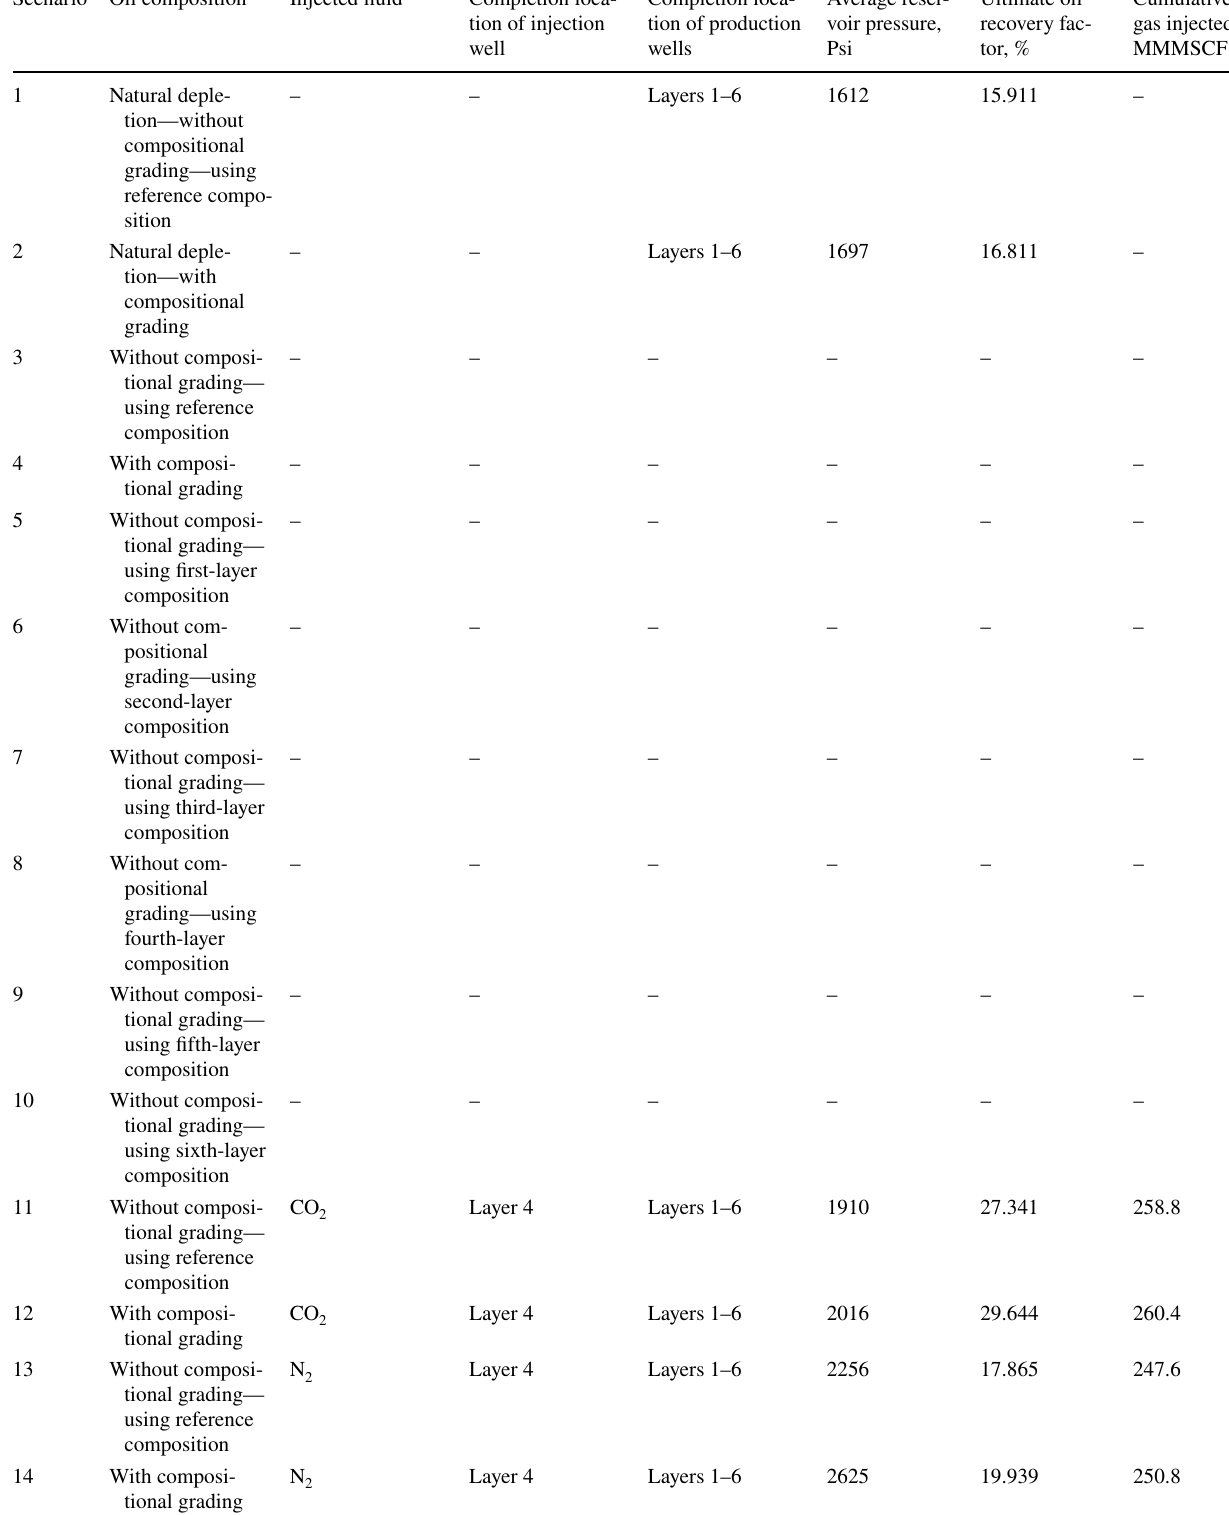
Table 6 Performance of the different injection gases with and without compositional grading in the reservoir understudy Scenario Oil